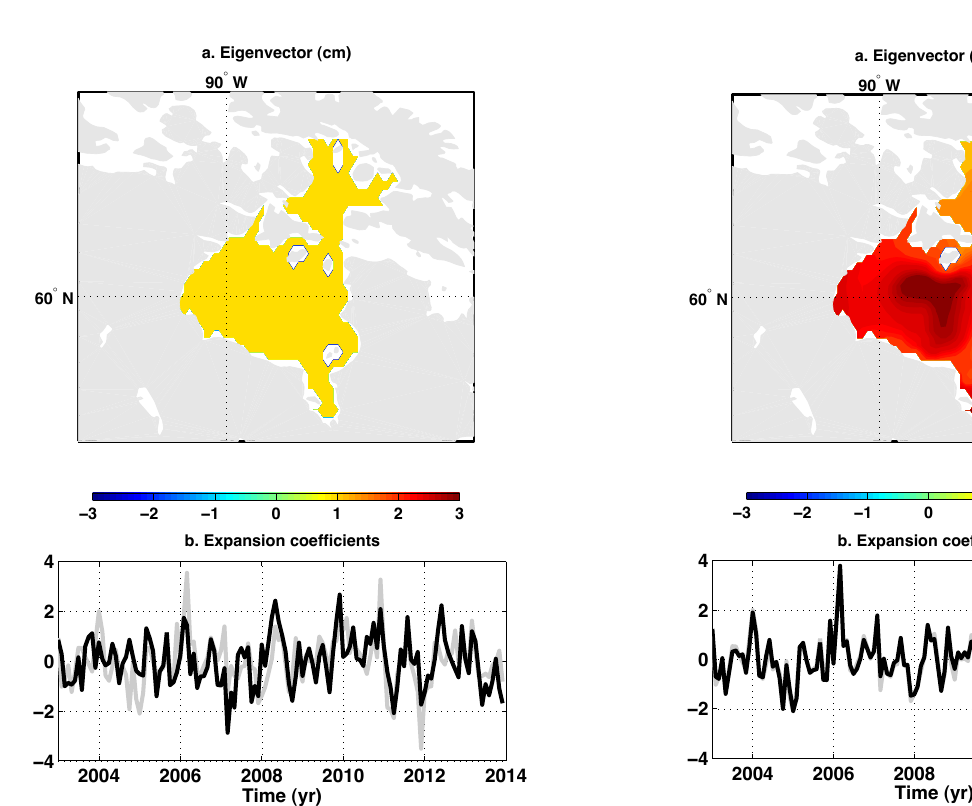
Figure 7. As in Fig. 4 but shown for the experiment driven only by wind stress over Hudson Strait. In (b) , the nonseasonal time series of the leading expansion coefficients from the baseline experiment is shown in gray for reference.